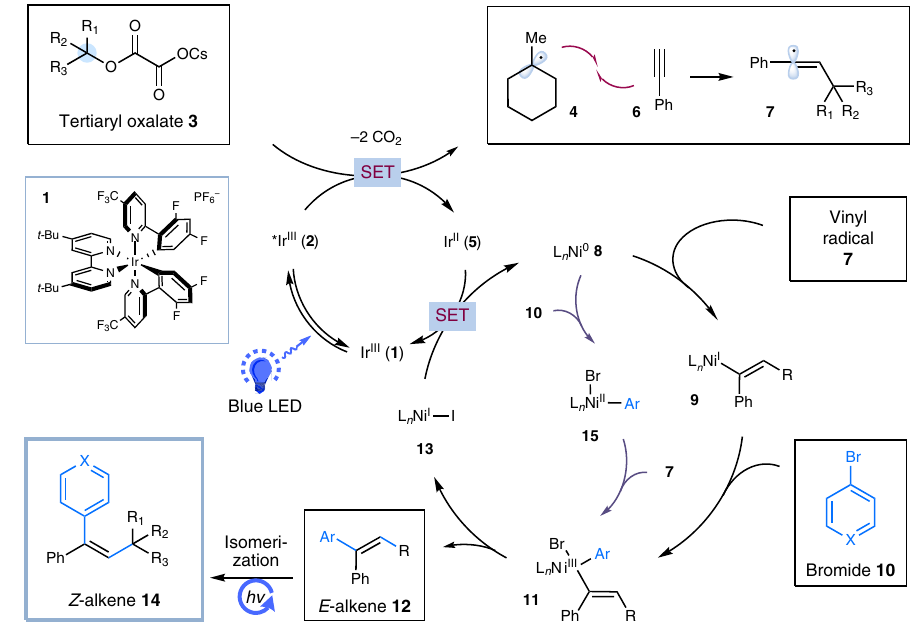
Fig. 2 Proposed mechanism. Two possible reaction pathways proposed on the basis of previous literature